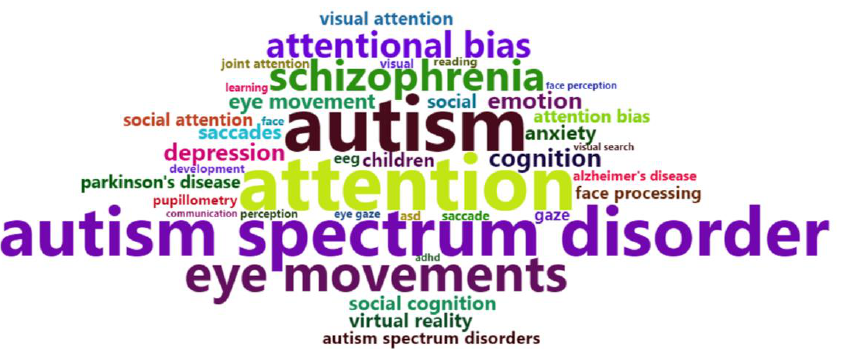
Figure 2. Word cloud based on the most frequent keywords of articles retrieved with the search. The size of the words is proportional to their frequency.